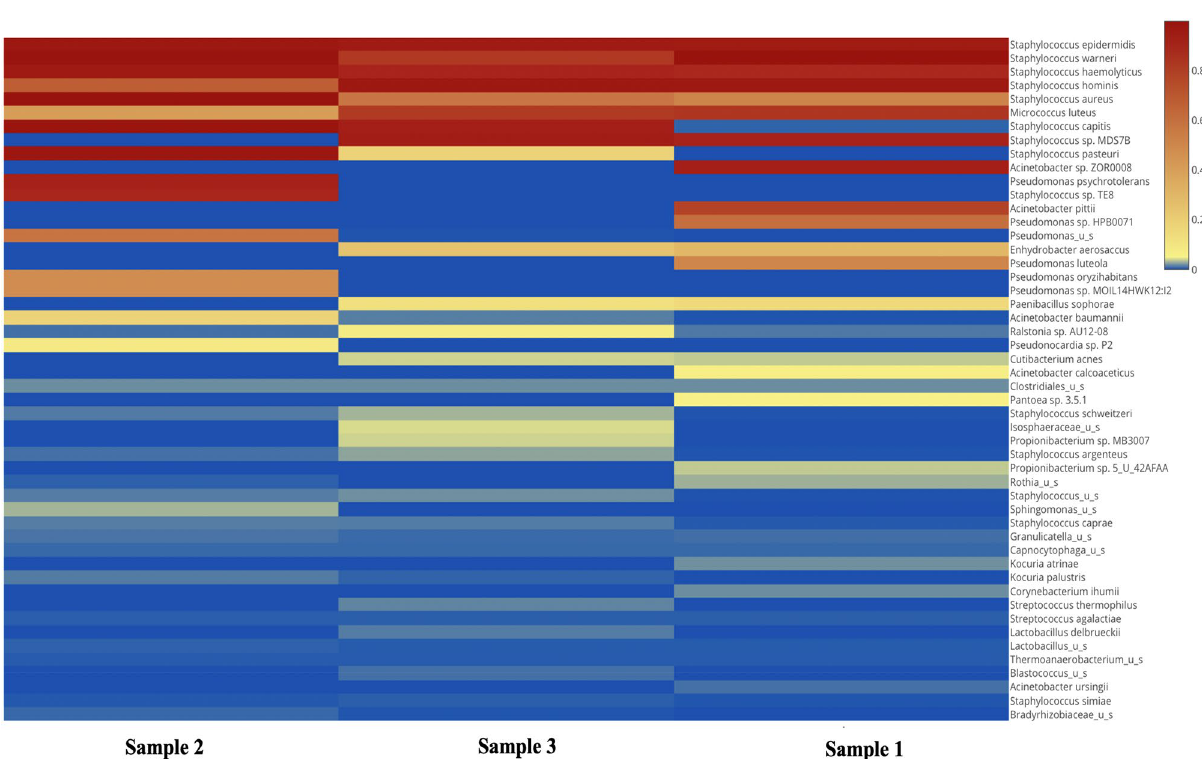
Figure 3. Heatmap visualisation of bacterial strains identified from community derived phone